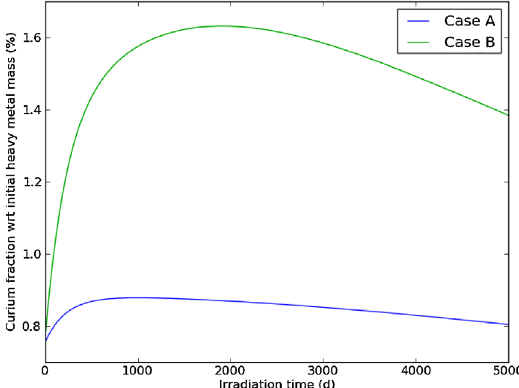
Fig. 4. Illustration of the curium peak for case A and B (detailed below in